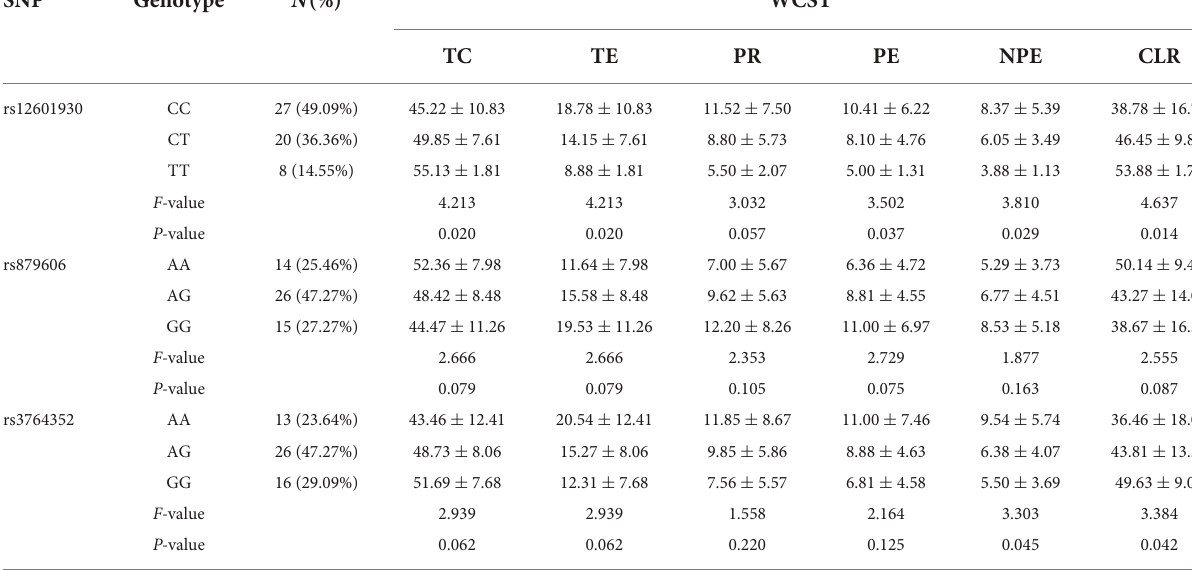
TABLE 2 Effects of PPP1R1B polymorphisms on WCST scores in males.